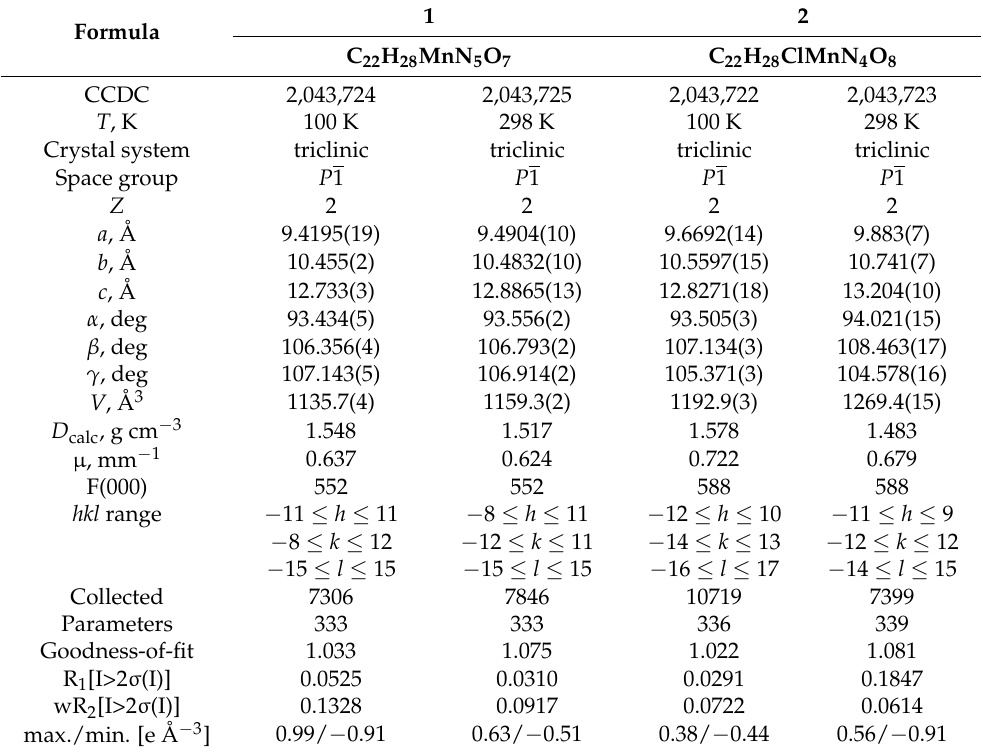
Table 1. Selected crystallographic data for complexes 1 and 2